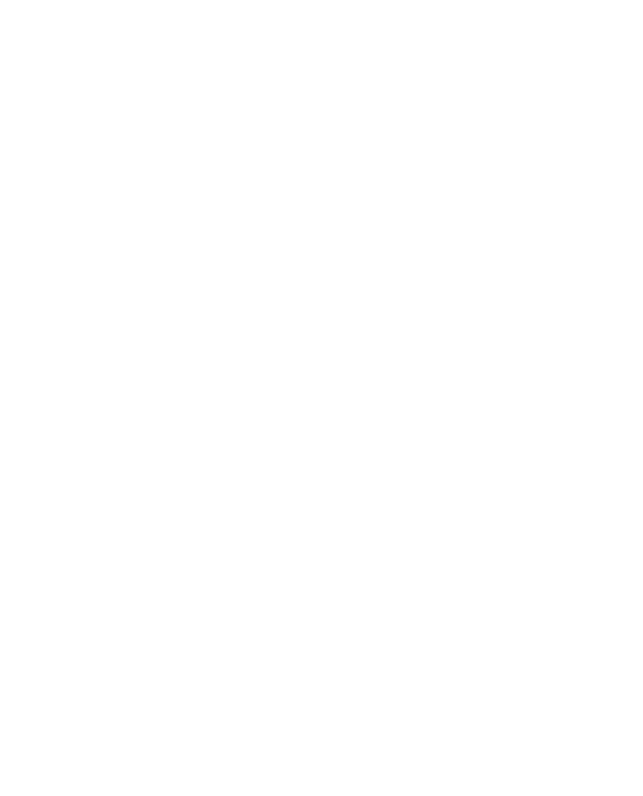
Figure S1 | Control subjects (CON, orange) and weight-restored individuals with anorexia (AN-Wr, green), show no difference in relative weight estimation between the four image categories when asked to rate images for body weight on a 9-point Likert scale (repeated measures ANOVA, subject group membership X image weight class; interaction term F = 0.42, p = 0.157). However, there were significant main effects of subject group membership ( F = 15.3, p = 0.001) and image category ( F = 409.8, p = 0). AN-WR subjects assigned significantly higher weight ratings across all image categories. Bars depict means + SEM.